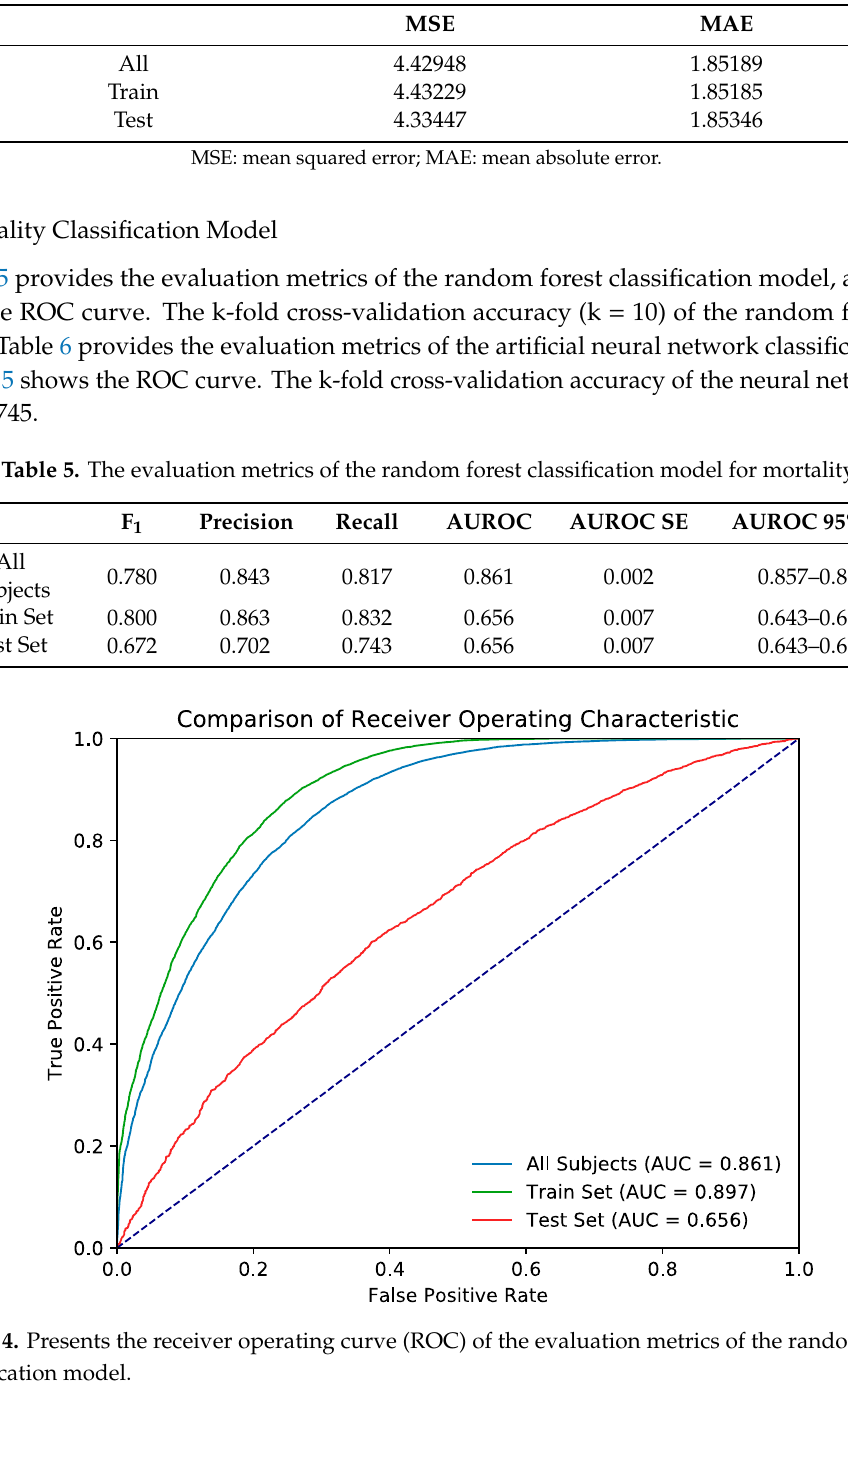
Figure 5. The ROC curve of the evaluation metrics of the artificial neural network classification model.